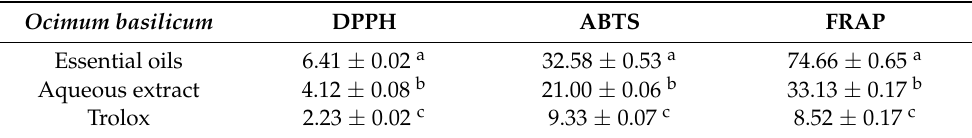
Table 5. IC 50 values (mg TEs/g) of the antioxidant activities of O. basilicum